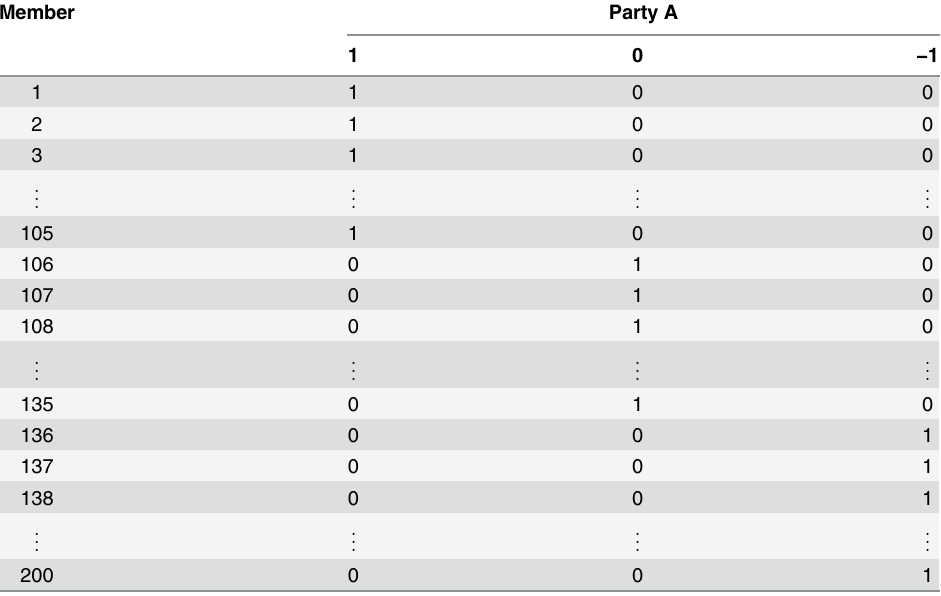
Table 3. A decomposition of Table 2 into multi-tables of Boolean-valued for Party A.